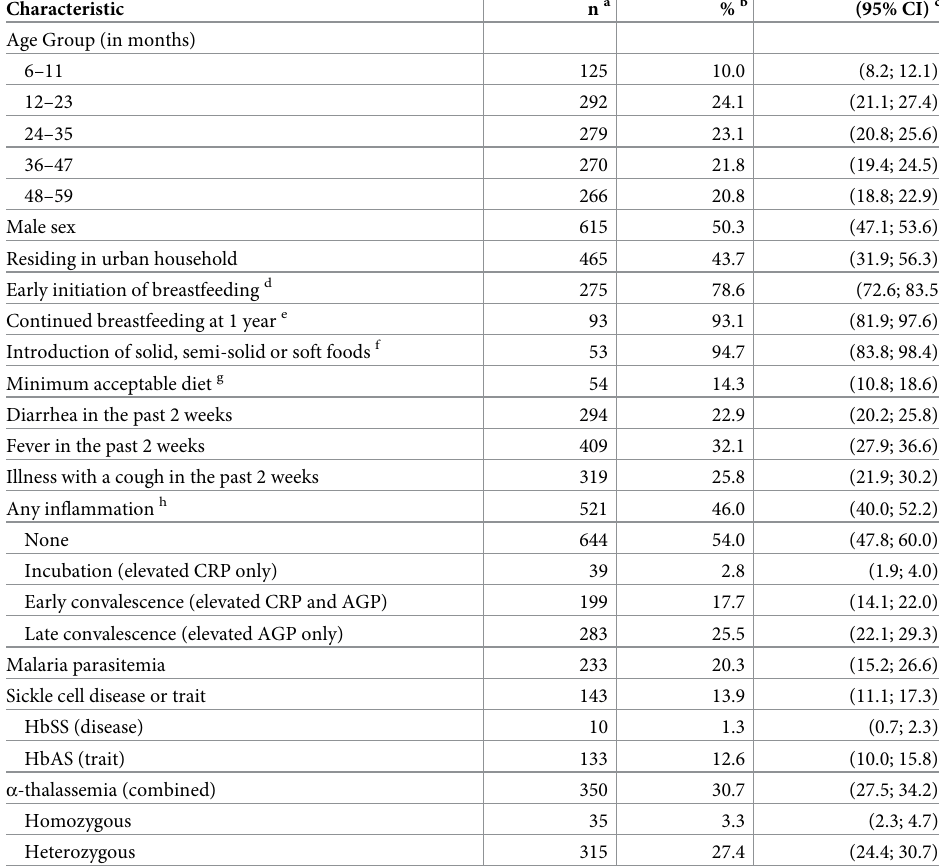
Table 1. Demographics, IYCF indicators, recent or current illness, infection and hemoglobinopathies among pre- school-age children, national, Ghana 2017. Characteristic n a % b (95% CI) c Age Group (in